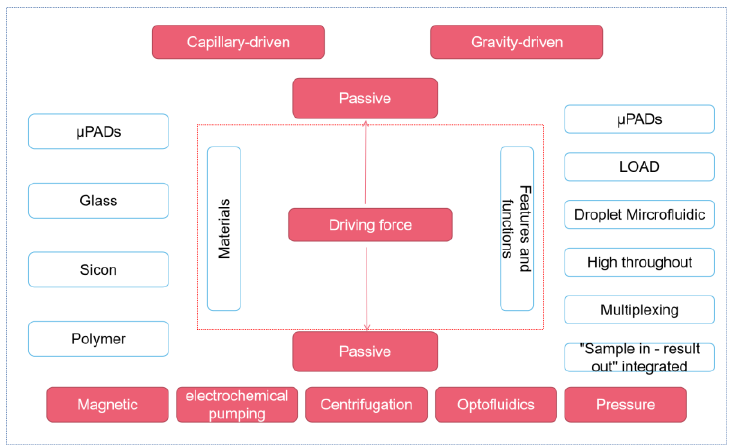
Figure 1. Different microfluidic platforms classified according to the driving force.